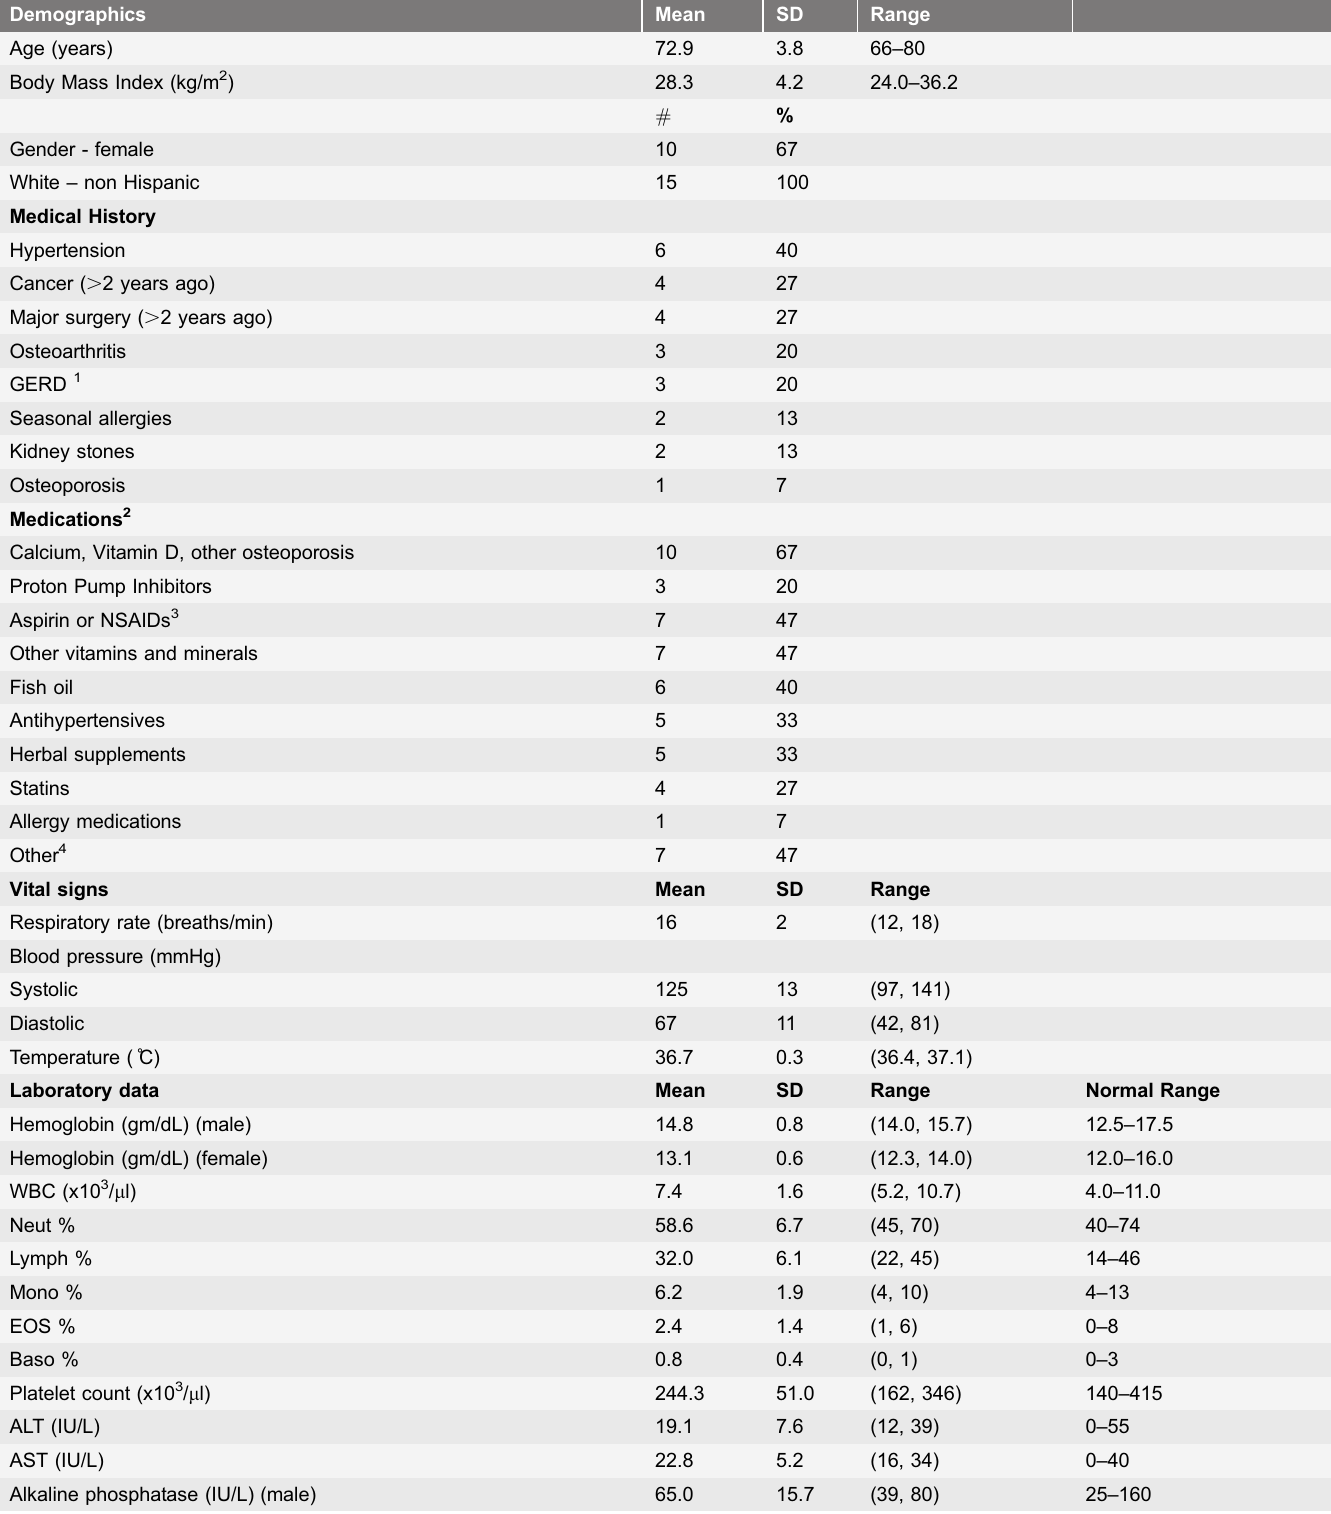
Table 3. Baseline characteristics of enrolled volunteers (N 5